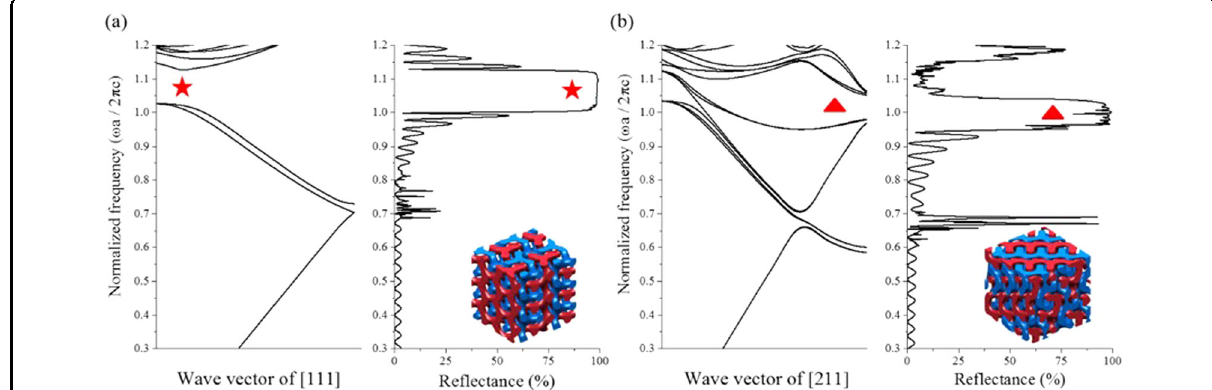
Fig. 4 Simulated photonic bandgap of gyroid-structured nanonetworks. The band structures and re fl ection spectra of fabricated gyroid- structured nanonetworks along a [111] and b [211] directions. The bandgap and corresponding high re fl ection areas are denoted by ★ and ▲ , respectively. The inset fi gures are the illustrations of the double gyroid structures with speci fi c